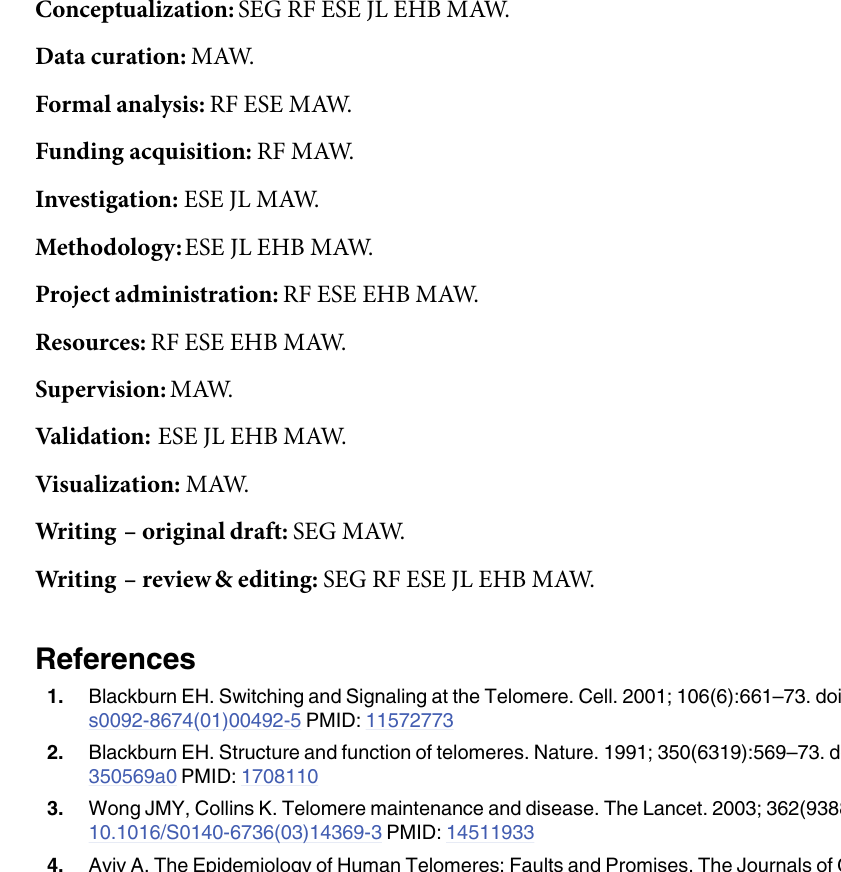
S1 Fig. Conversion of T/S ratios to base pairs. (JPG) S2 Fig. Telomere length by age in 608 participants. a. Upper left: Telomere length at base- line exam by age at year 6 (p < 0.001). b. Upper right: Telomere length at year 6 by age at year 6 (p < 0.001). c. Lower left: Crude change in telomere length by age at year 6 (p = 0.10). d. Lower right: Change in telomere length adjusted for baseline telomere length by age at year 6 (p < 0.001). (JPG) S3 Fig. Distribution of leukocytetelomere length at baseline and after 5 years of follow-up (reproducedfrom Farzenah-Far, PLOS One 2010).